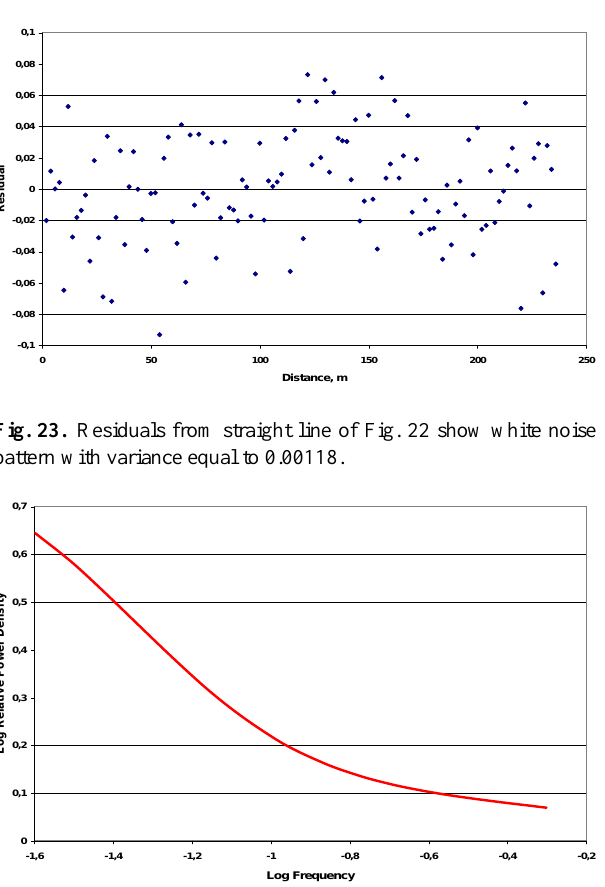
48 Fig. 24. Relative power spectrum for autocorrelation function shown in Fig. 12. Decrease in slope at higher frequency side is caused by the nugget effect (Logarithms base